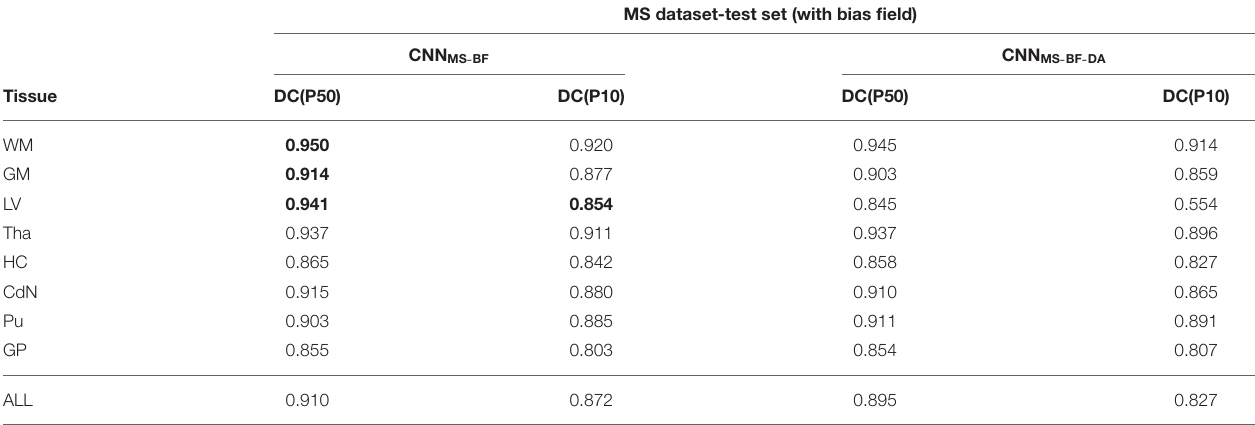
TABLE 5 | Summary of the performance of models trained and evaluated on data with bias field on MS dataset.